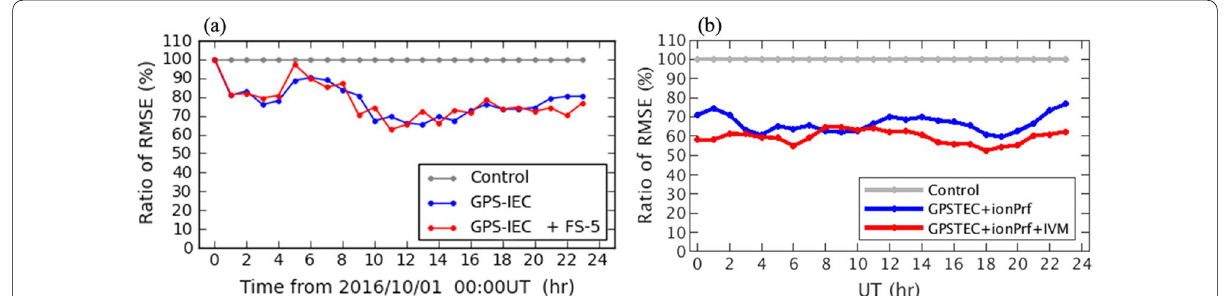
Fig. 16 RMSE temporal variations for the cases with and without assimilating [ O + ] flux from FS‑5/AIP ( a ) and F7/C2‑IVM ( b ). Gray lines are the case of default TIEGCM. Blue (red) lines are the case with (without) assimilating [ O + ] flux. Here IEC is the integrated electron content from 100–2000 km. The RMSE values are plotted as ratios with respect to the control run values in